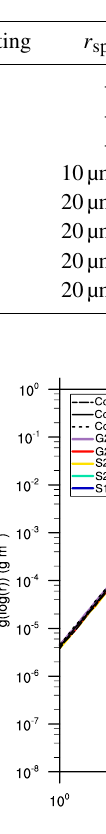
Table 1. Summary of the main parameters for the single-cloud simulations.